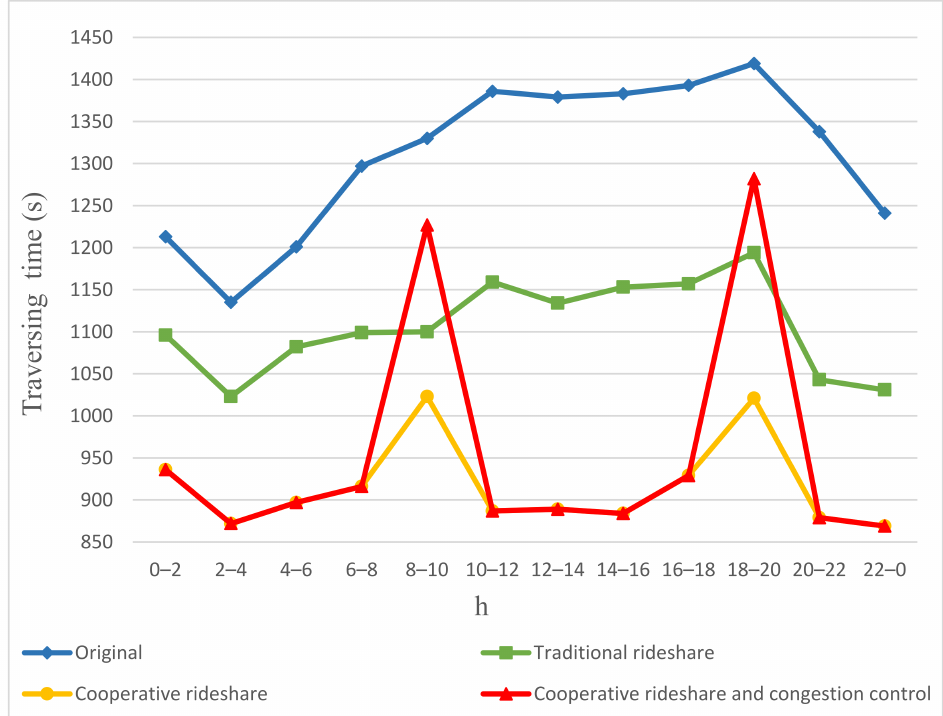
Figure 19. Traversing times of PEV/SAEV passengers on the municipal